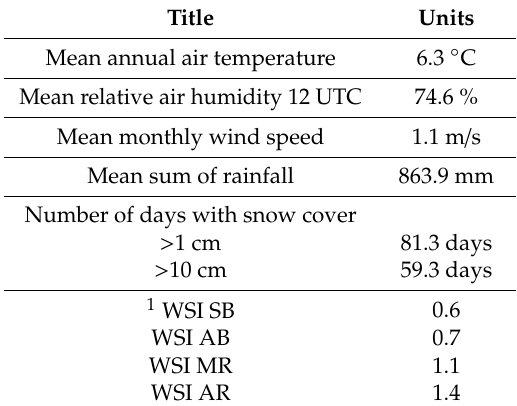
Table 1. Selected values of meteorological parameters and bioclimatic indicators (based on [11]).